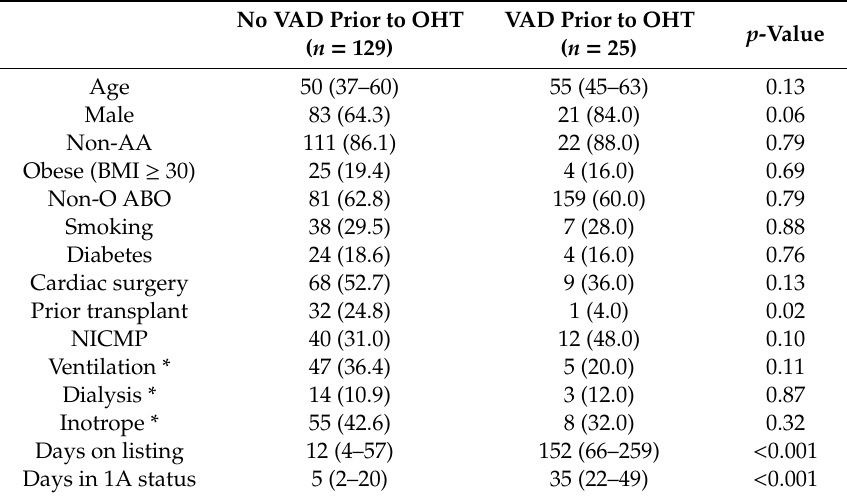
Table 4. Demographic and clinical characteristics in patients who were transplanted with vs. without VAD implantation during listing.